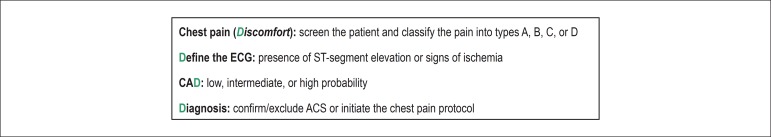
Care systematization for the establishment of the diagnosis in patients with
chest pain. ECG: electrocardiogram; CAD: coronary artery disease; ACS: acute
coronary syndrome.